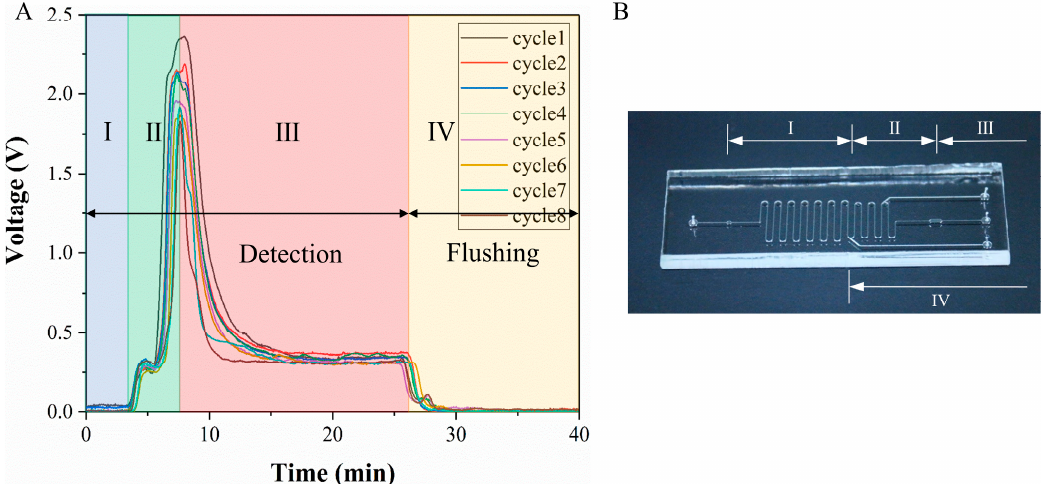
Figure 6. Correspondence between detection signal and chip structure. ( A ) Detection signal. ( B ) Image of the microfluidic chip.